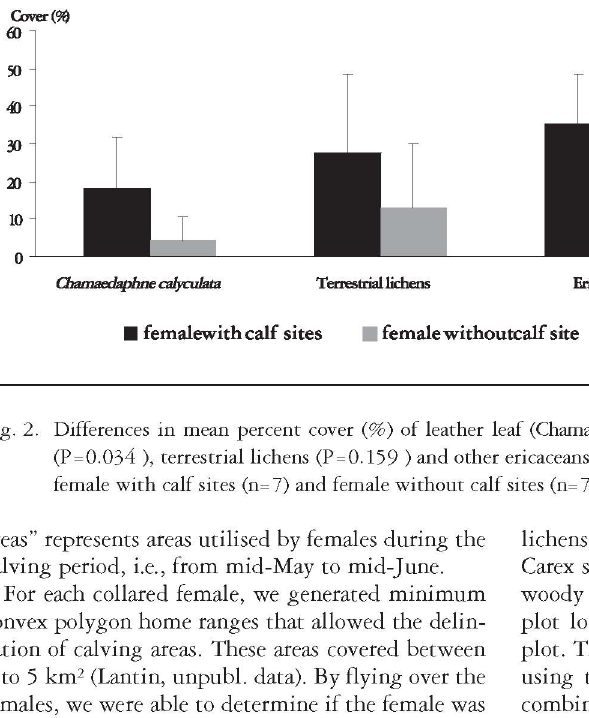
direction). When no calf was seen with the female or